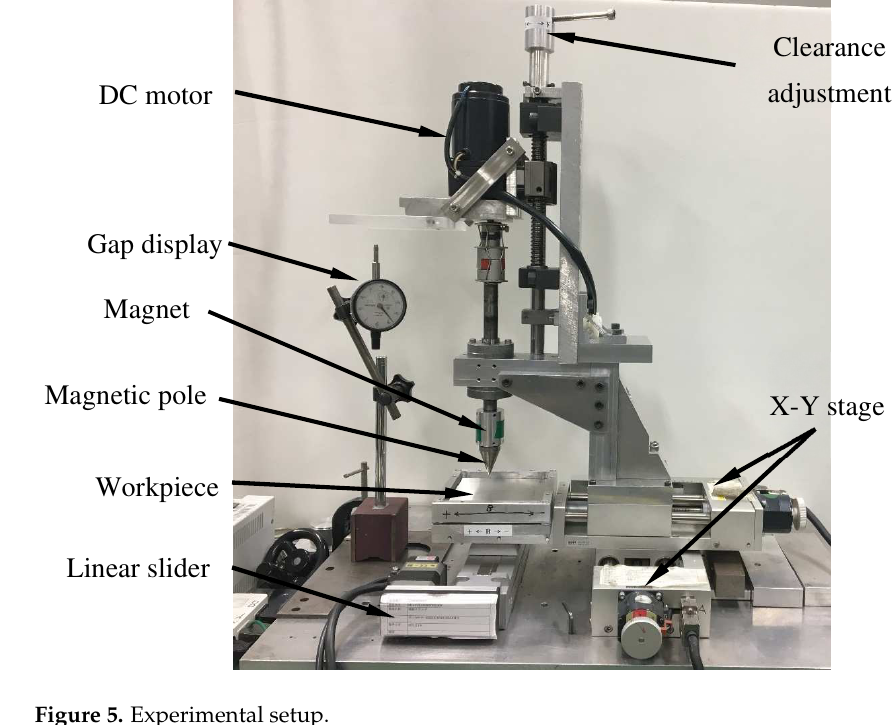
Figure 5. Experimental setup.